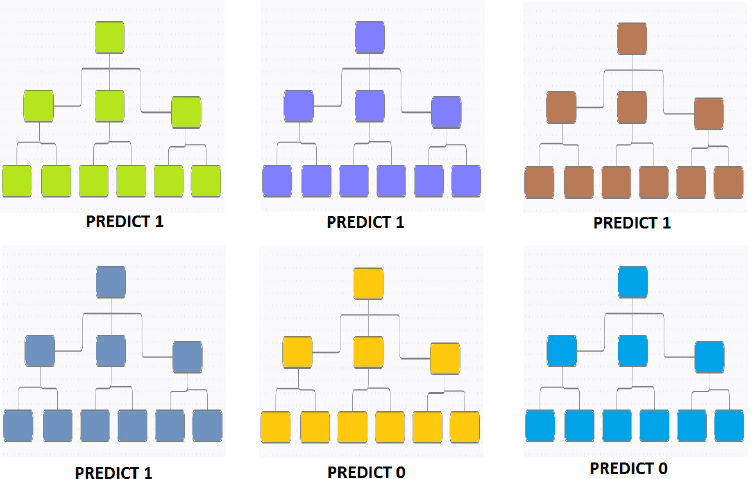
Figure 6. Ensemble decision tree structure that makes up a random forest classifier. The tally was four 1’s and two 0’s, thus resulting in prediction = 1.